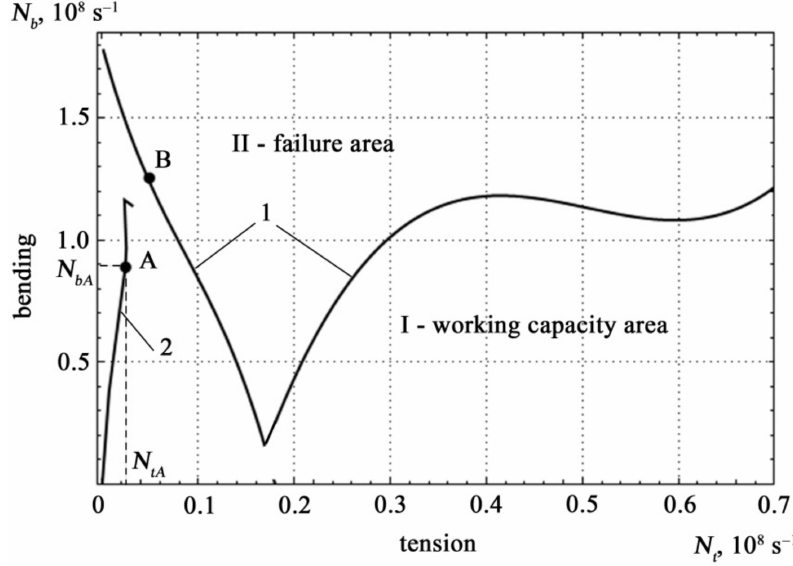
Figure 10. Boundary curve 1, possible loading trajectory 2 and areas of working capacity and fracture states under tensile and bending